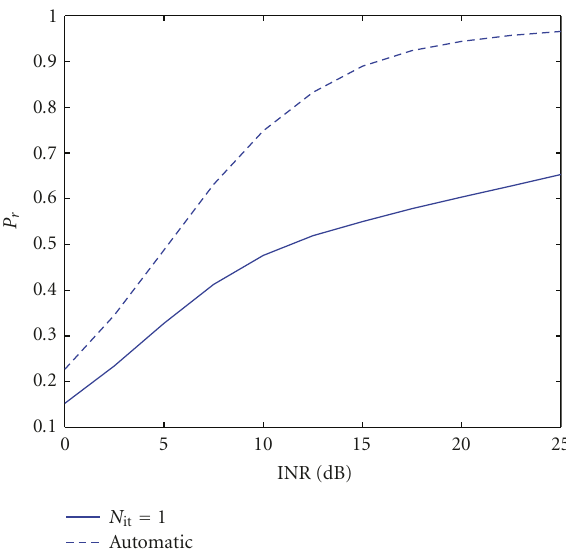
Figure 11: Test statistic versus range in real sea clutter. One interfering target INR = 10 dB. Data from file 19980223 − 165836, with N = 8, K = 32, N it = 1, and P e